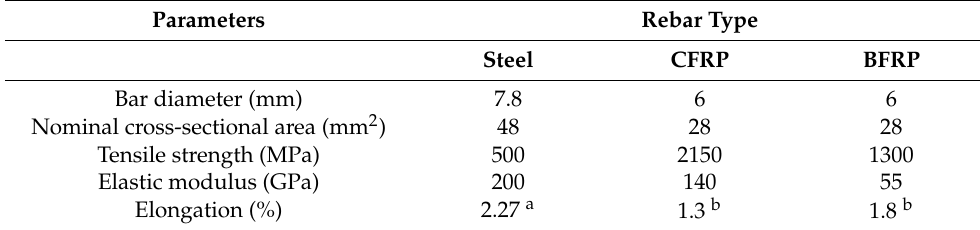
Table 1. Properties of the reinforcing bars (taken from manufacturing data sheet).